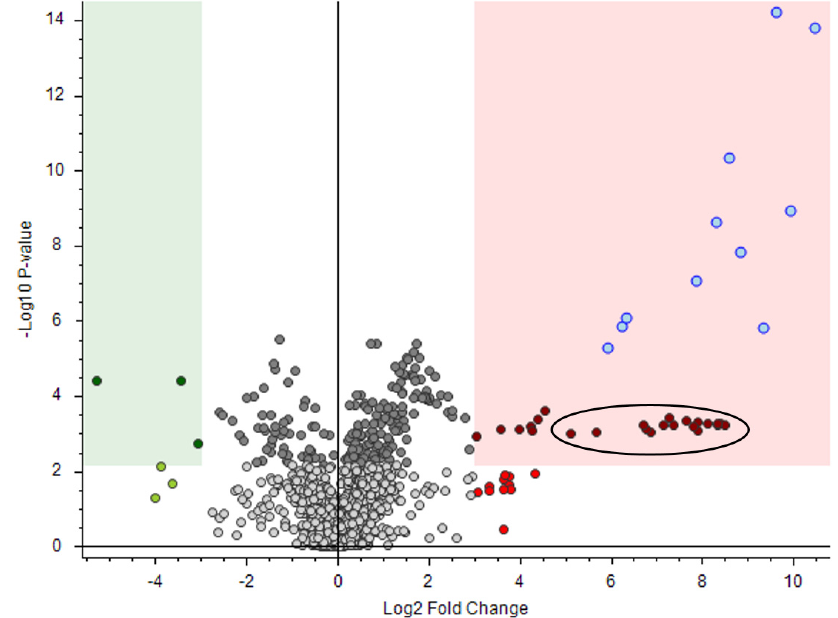
Figure 5. Differential analysis in order to reveal the spiked compound (labeled in blue) in the experiment described in Section 3.2. Seven samples from the same DWTP as the spiked sample (but other months) were used as reference samples. Encircled are the matrix compounds that showed lower significance in this experimental setup as compared to the setup described in Figure 4 (see also text). For further details regarding volcano plots, see Figure 3 and text.